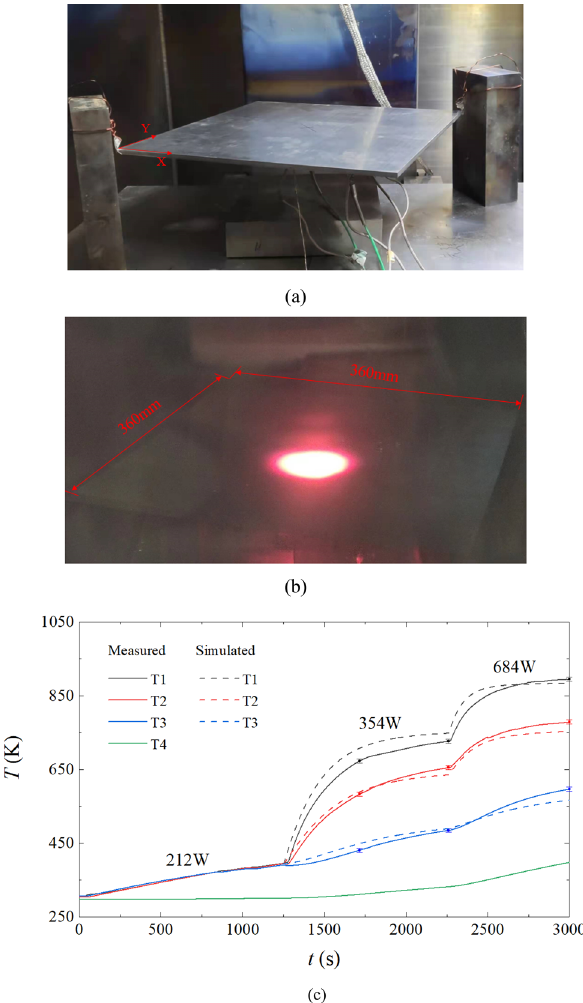
Figure 6. The photos for the experiments and the simulated and measured temperatures. ( a ) The workpiece hanging above the platform. ( b )The experimental phenomenon of the non-uniform heating. ( c ) Simulated and measured temperatures of the TC4